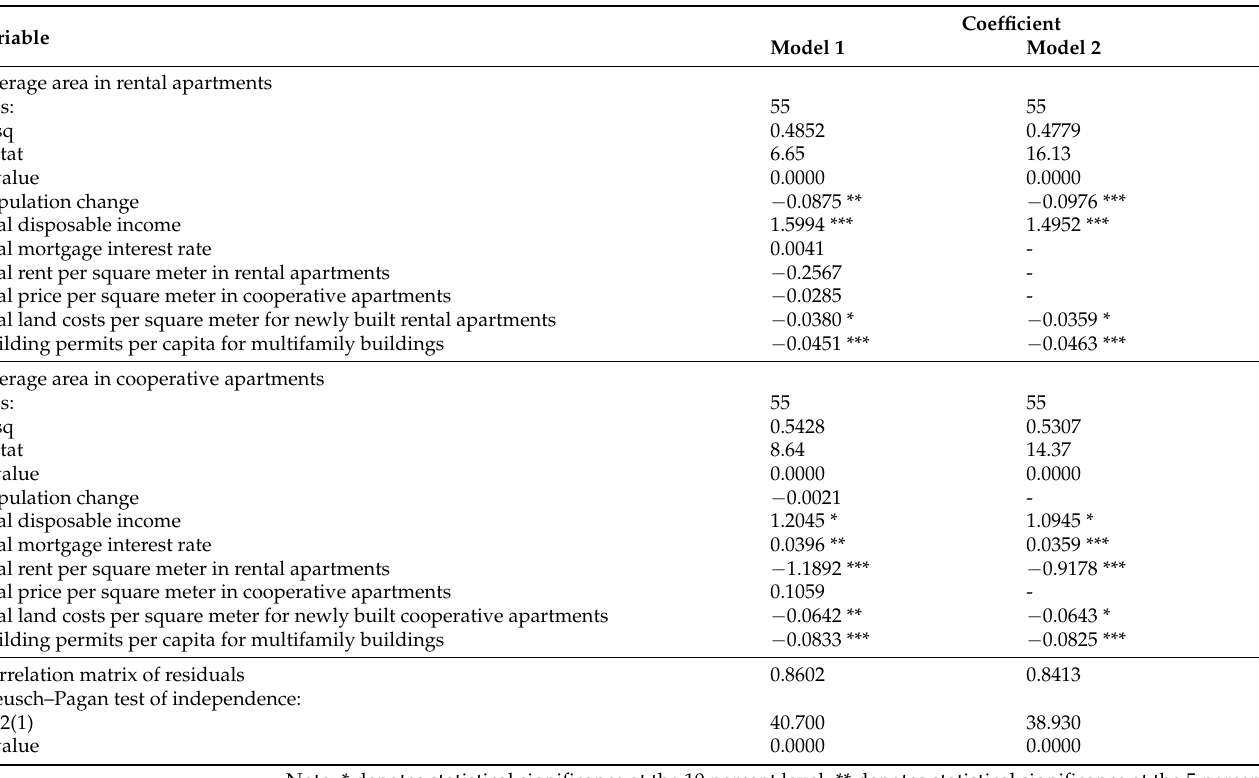
Table 4. SUR regression results on model for first